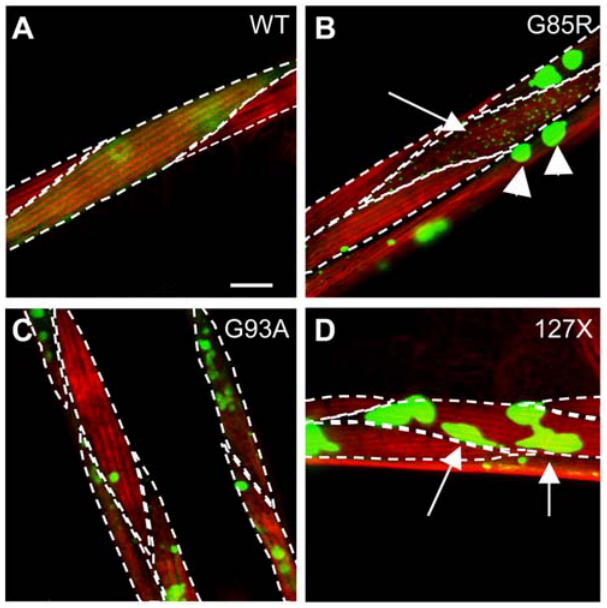
Figure 3. Mutant SOD1 forms morphologically distinct aggre- gates. Projections of confocal Z-stacks with several adjacent muscle cells; punctate lines delineate individual cells, red staining shows myofilaments stained with Rhodamine-phalloidin. G85R protein ( B ) forms morphologically diverse aggregates, including large foci indicat- ed by arrowheads and small dispersed foci, indicated by arrow. Aggregates in about 40% of cells of 127X animals appear as irregular, elongated foci ( D , arrows and inserts in Figure 1 J–L ). Scale bar in A is 10 micrometers. Images are selected as representative of typical aggrega- tion morphology among at least 100 imaged cells per